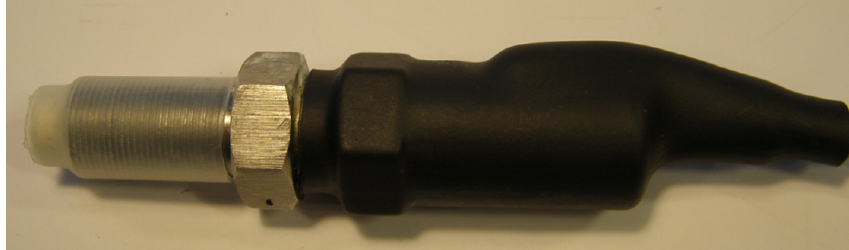
Figure 4. Inductive sensor-photo.